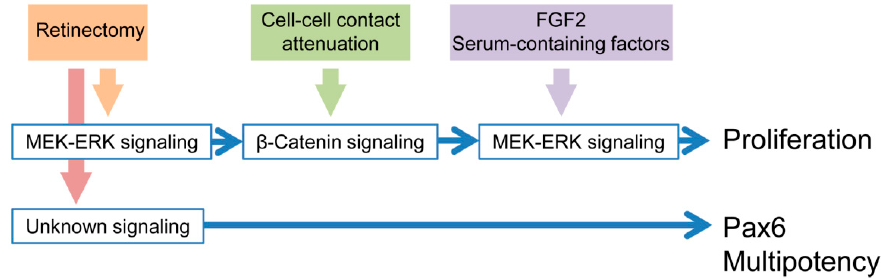
Figure 8. Conclusion. Retinal regeneration of the adult newt is triggered in a multi-step manner.